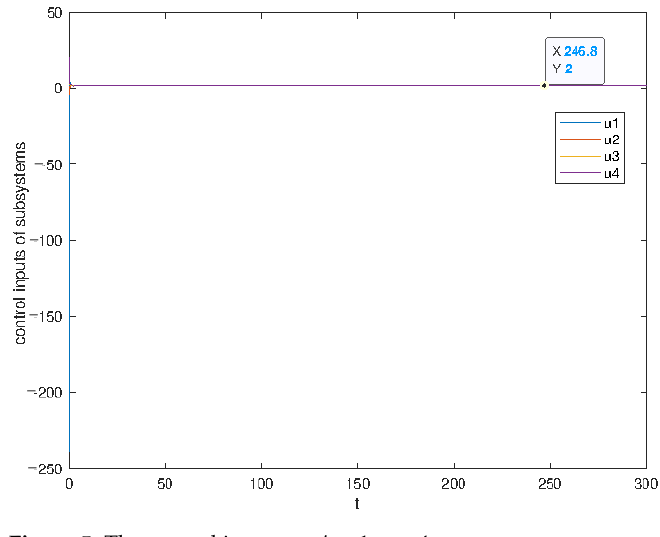
Figure 5. The control inputs u i , i = 1, . . . ,4.